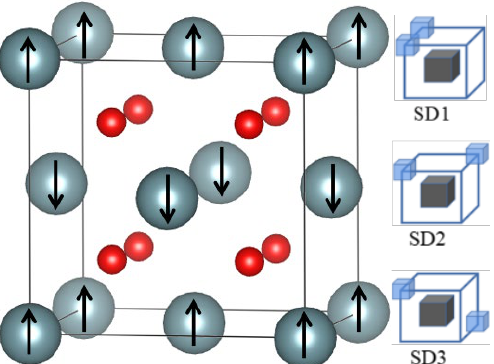
Figure 1. Structure of UO 2 and Schottky defect configuration. The red and grey balls are oxygen and uranium atoms, respectively. The arrows on the uranium atoms illustrate the magnetic moment directions in a 1 k spin-polarized AFM state. Black means uranium vacancies and blue means oxygen vacancies.